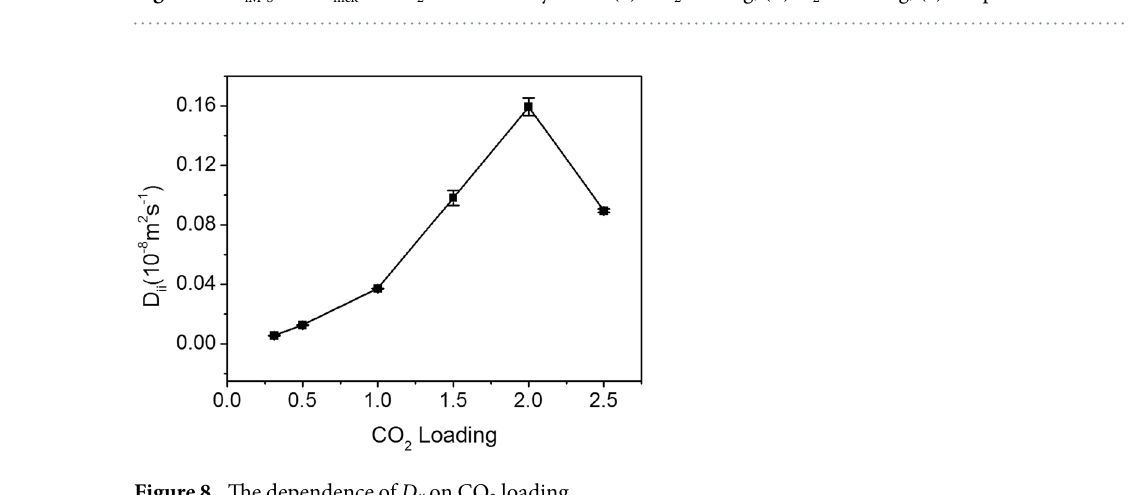
Figure 7. D iM-S and D ifick of CO 2 in different systems: ( a ) CO 2 loading; ( b ) H 2 O loading; ( c ) temperature.